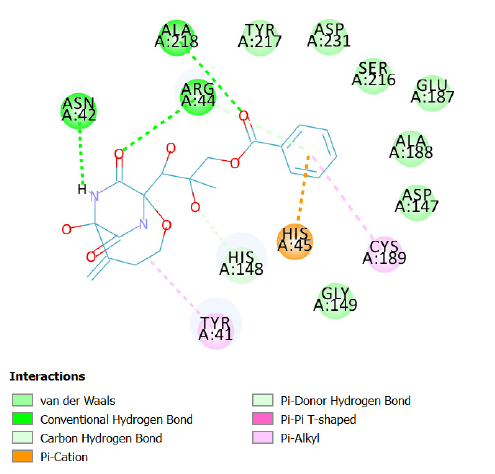
Fig. 3A. 2D diagram showing interactions of Bicyclo- mycin benzoate at LGMN catalytic site.